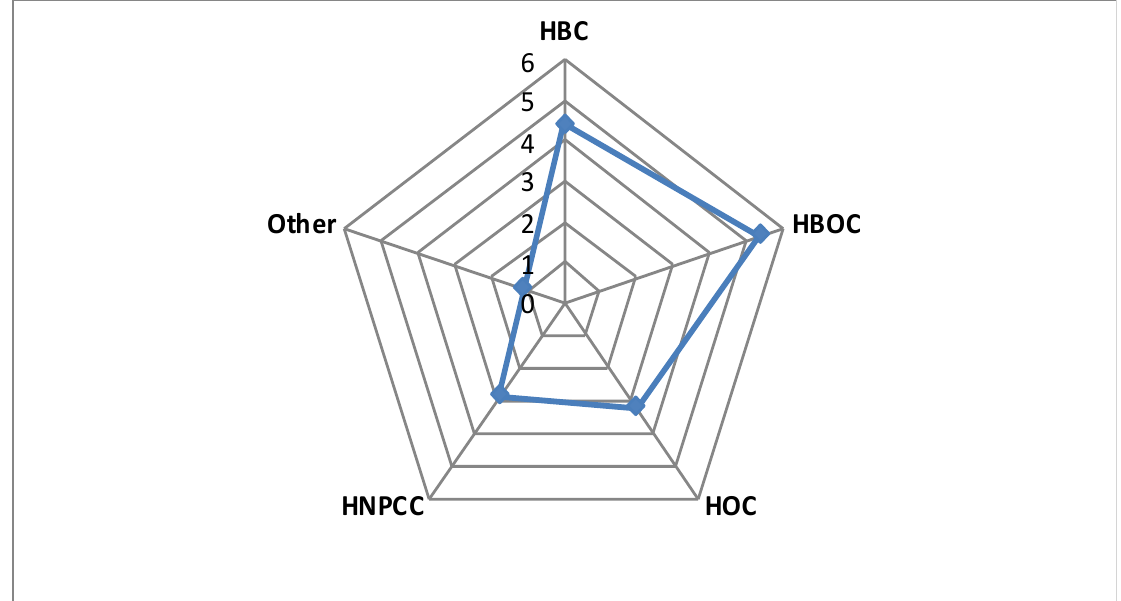
Figure 1. The diagram represents the percentage of pathogenic variants in the 14 Fanconi anemia (FA) genes analyzed per clinical suspicion group. HBC: Hereditary Breast Cancer Patients; HOC: Hereditary Ovarian Cancer Patients; HBOC: Hereditary Breast and Ovarian Cancer Patients; HNPCC: Hereditary non-polyposis colorectal cancer.